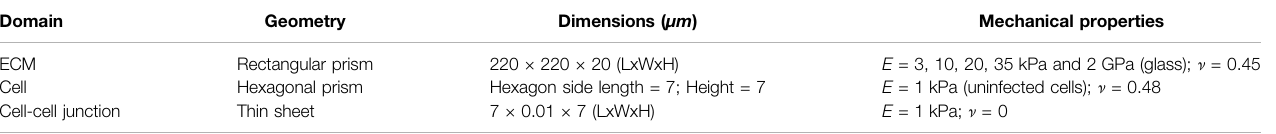
TABLE 1 | Summary of the features of the computational model. Domain